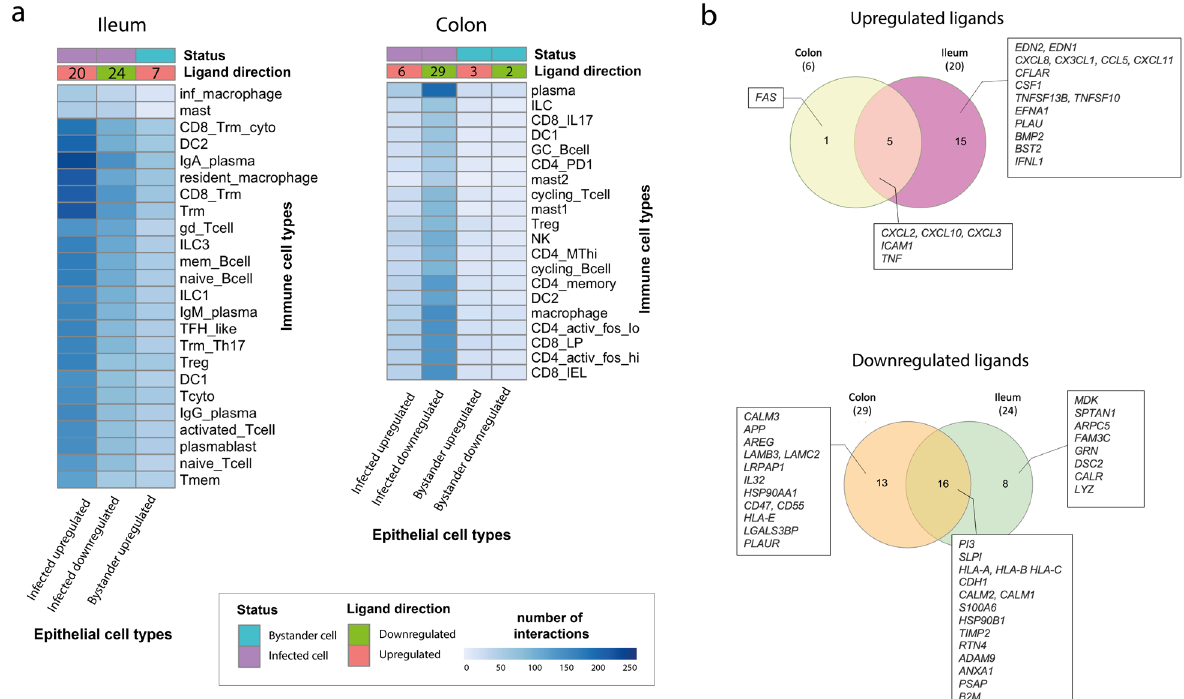
Fig. 2 Differentially expressed ligands driving upregulated and downregulated intercellular interactions between colonic and ileal infected immature enterocytes and resident immune cells upon infection in the colon and ileum. a Heatmap showing the number of interactions between immature enterocytes and resident immune cells. Interactions driven by upregulated and downregulated ligands (ligand direction) are shown separately for infected and bystander cells (status), and for ileum and colonic organoids. The intensity of the colour indicates the number of interactions with the immune cell types whose receptor is targeted by the epithelial cells ligands. The numbers on the ligand direction row refer to the number of upregulated or downregulated ligands driving the indicated interactions with immune cells for the different groups/conditions. Abbreviations: Ileum: inf_macrophage infected macrophage, mast mast cell, CD8_Trm_cyto Resident memory cytotoxic T cell, DC2 dendritic cell 2, Trm Tissue-resident memory T cell, gd_Tcell Gamma delta ( γδ ) T cells, ILC Innate lymphoid cell, mem_Bcell memory B cell, naive_Bcell naive B cell, TFH_like T follicular helper cells, Trm_Th17 Tissue-resident memory Th17 cells, Treg Regulatory T cell, Tcyto Cytotoxic T cell, Tmem Memory T cells. Colon : ILC Innate lymphoid cell, CD8_IL17 IL-17 + CD8 + T cells, DC dendritic cells, GC_Bcell Germinal center B cells, CD4_PD1 mast mast cell, Treg Regulatory T cell, NK Natural Killer cell, CD4_MThi high mitochondrial CD4 + T cell, CD4_memory CD4 + Memory T cell, CD4_activ_fos_high activated CD4 + T cells (high/low c-fos), CD8_LP CD8 + lymphocyte- predominant cells, CD8_IEL CD8 + intraepithelial lymphocytes. b Venn diagrams showing the number of ligands of the infected immature enterocytes – immune cells intercellular network that are unique or shared between the ileum and colon. Upregulated and downregulated ligands are shown separately. The full list of ligands is available as Table